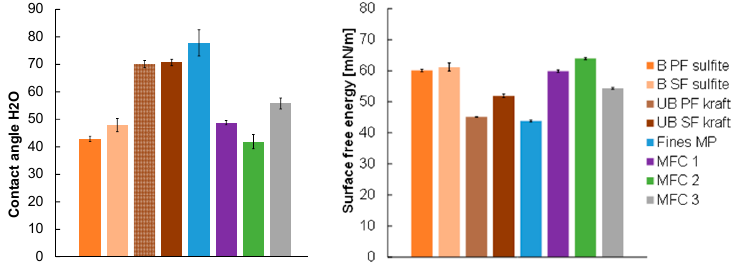
Figure 9. Static water contact angles of the paper sheets ( Left ) and the corresponding surface free energies determined by the Owens-Wendt-Rabel-Kaelble (OWRK)approach ( Right ). As apolar liquid diiodomethane was used.